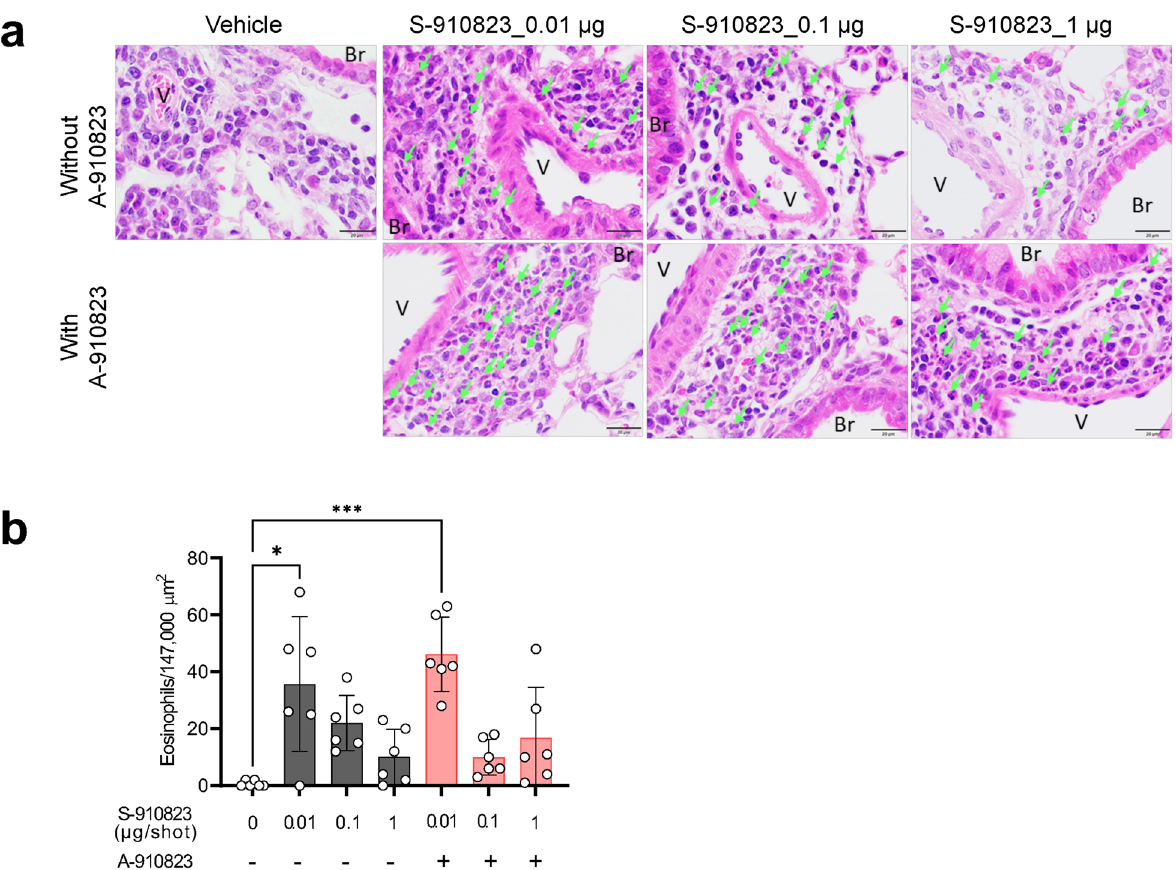
Figure 3. Eosinophilic infiltration in the lungs of vaccinated mice after challenge infection with severe acute respiratory syndrome coronavirus 2 (SARS-CoV-2). Lung specimens were collected at the humane endpoint or 10 d post-infection. The study schedule is described in detail in Fig. 2. ( a ) Representative histopathological findings from mice with the highest levels of eosinophilic infiltration. Infiltration was detected using eosinophilic staining with a combined eosinophil mast cell (C.E.M.) staining kit. Scale bar = 100 μm. Green arrows indicate representative eosinophils. Br, bronchus; V, blood vessel. ( b ) Number of eosinophils per lung section. The number of eosinophils in five regions with an area of 147,000 μm 2 around the pulmonary bronchioles of each mouse was counted at 40 × magnification. Each circle represents the results of individual animals. The bar represents the mean number of eosinophils (error bars indicate standard deviation). Statistical significance was determined using a nonparametric comparison test, followed by the Kruskal–Wallis test (* P < 0.05 and *** P <